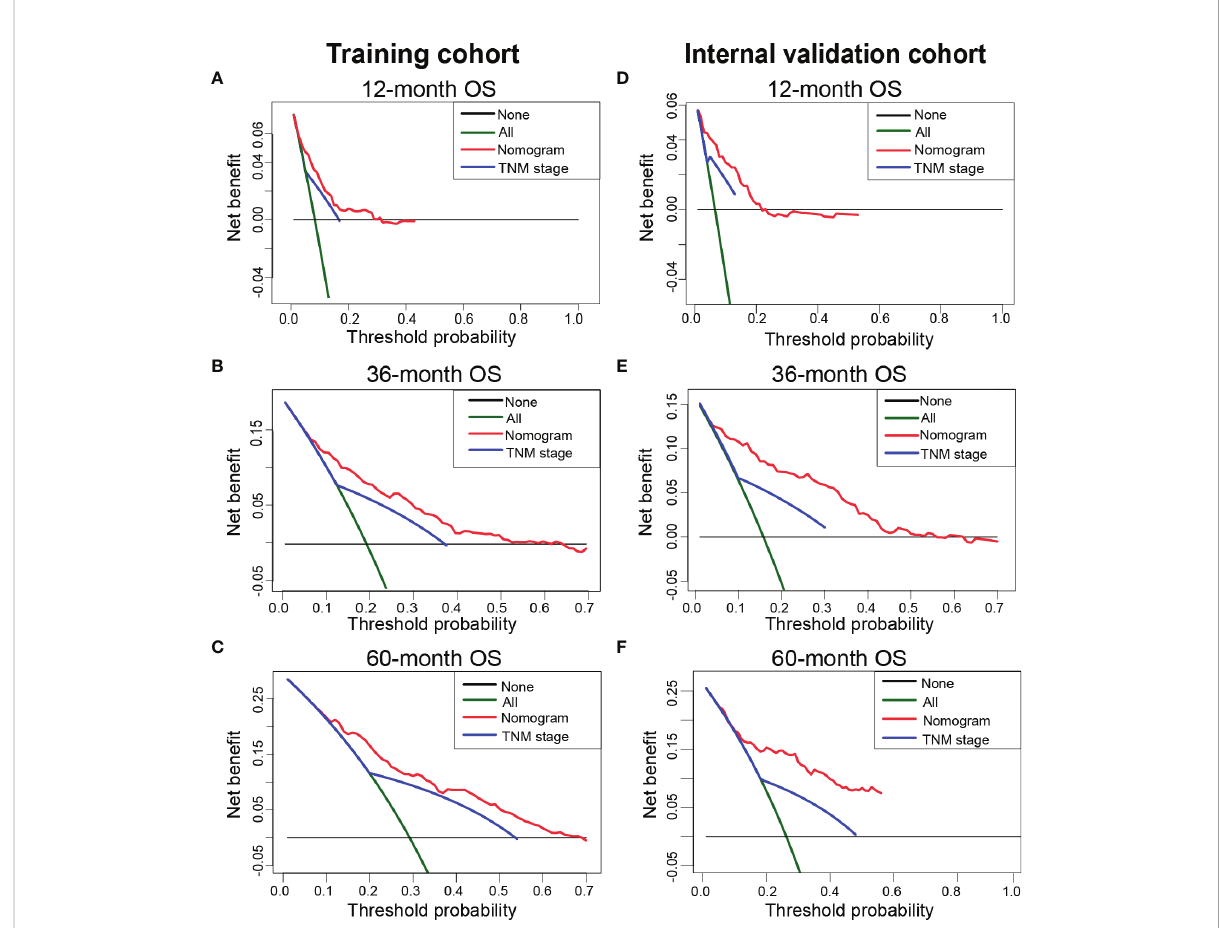
FIGURE 4 Decision curve analysis to compare the net clinical bene fi ts of the nomogram and classic TNM staging system when they were adopted to guide clinical practice. (A – C) The net clinical bene fi ts of 12- (A) , 36- (B) , and 60-month (C) OS in the training cohort. (D-F) The net clinical